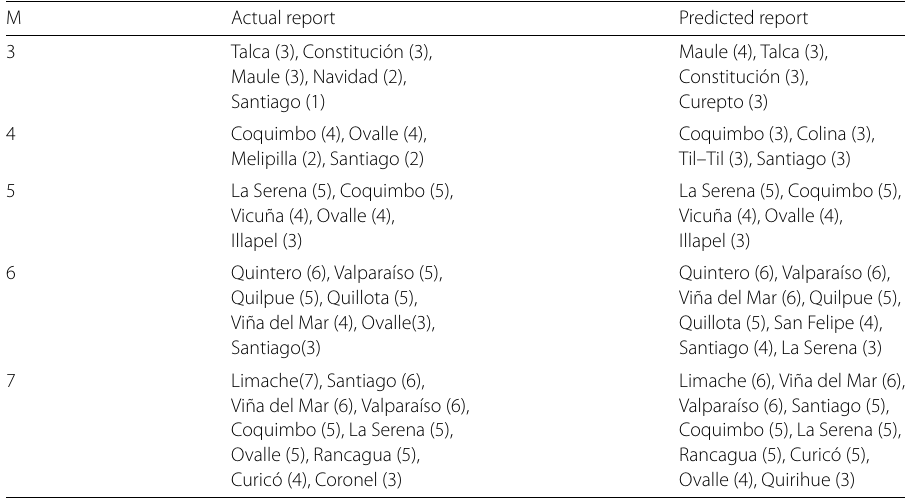
Table 11 Illustrative examples of spatial Mercalli reports comparing actual and predicted Mercalli